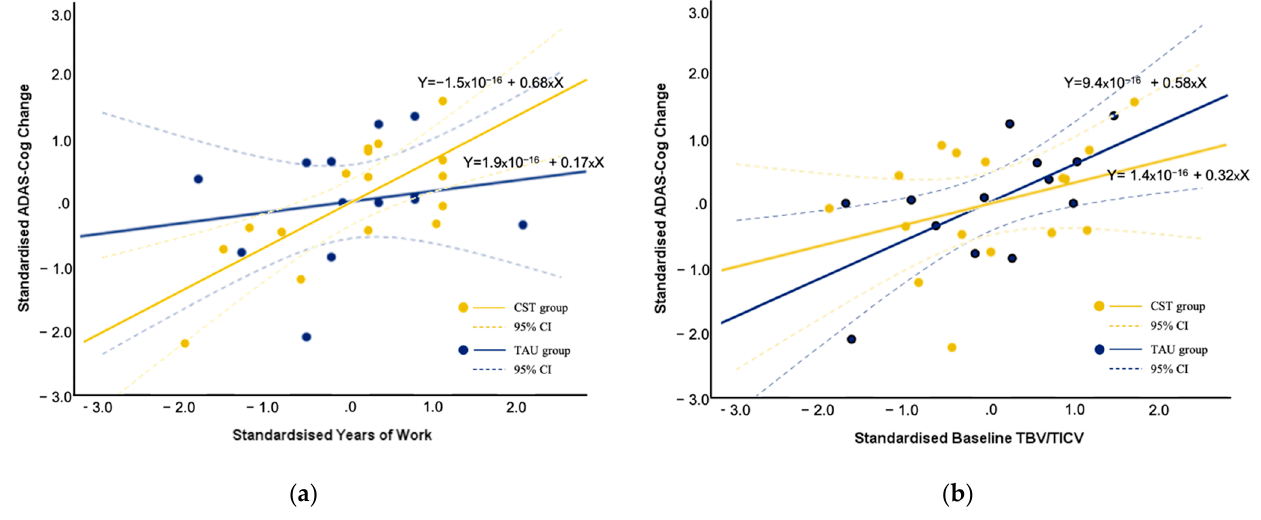
Figure 2. Relationship between ( a ) standardised years of work and ( b ) standardised baseline TBV/TICV with standardised ADAS-Cog changes controlled for age and gender. Positive values signify improvement on ADAS-Cog. Table 3. Partial correlation between baseline network connectivity and cognitive changes control- ling for age and gender, and Fisher’s Z transformation.